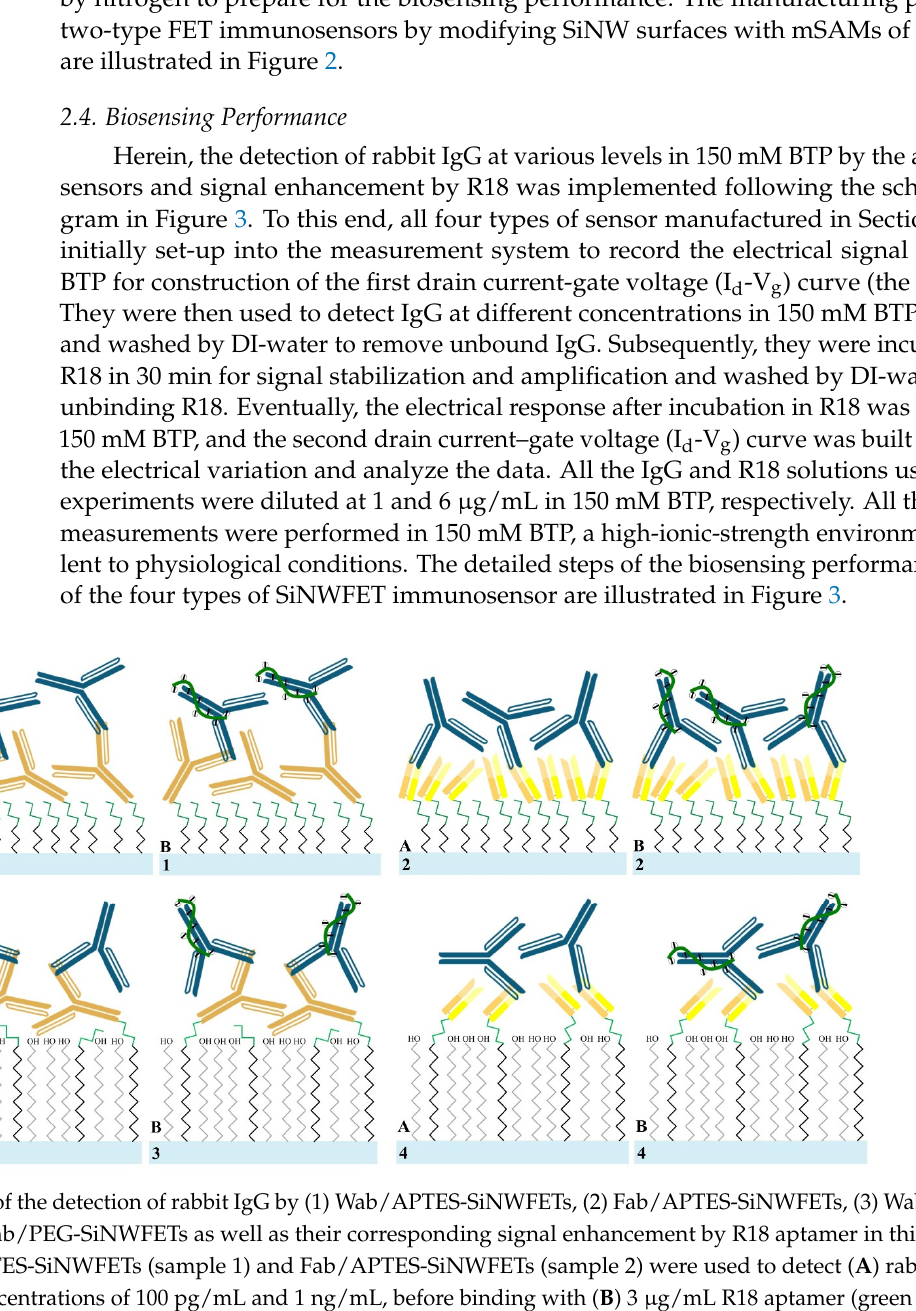
Figure 4. ( A ) Verification of immobilization method with PEG-mSAMs and target-probe binding by indirect ELISA on silica surfaces. Absorbance at 450 nm of pure water (black bar), silica sample modified with PEG-SAMs and GA but with- out immobilizing IgG (negative control (NC), yellow bar), silica sample prepared with IgG immobilization after modifying